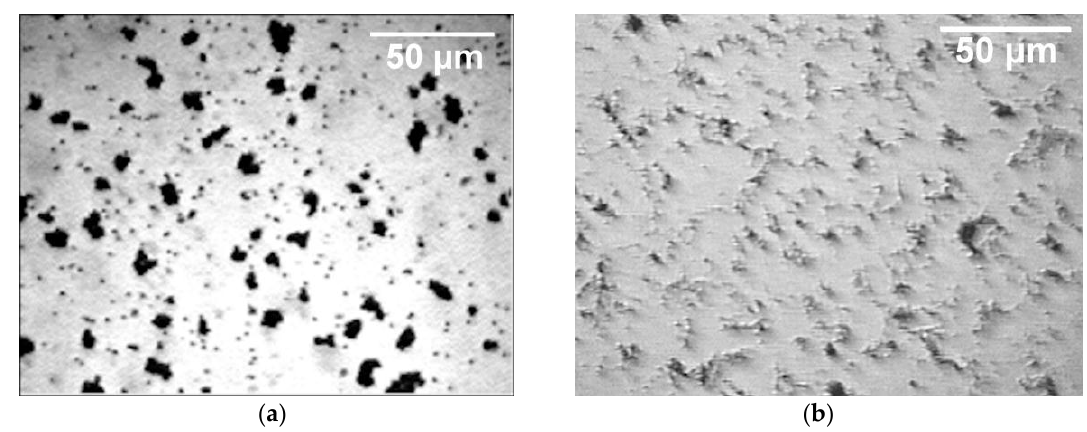
Figure 9. Images of the PS particle aggregates on the nickel substrate after 10 min of deposition in ( a ) CTAB and ( b ) CTAC solution.